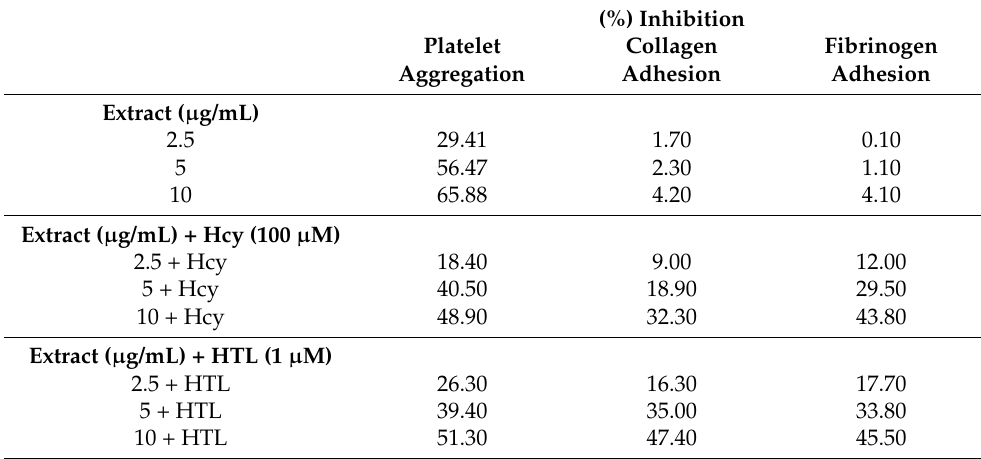
Table 5. Inhibitory effects of different extracts of A. melanocarpa combined with Hcy (homocysteine) and HTL (homocysteine thiolactone) on platelet aggregation and adhesion [121]. (%) Inhibition Platelet Collagen Fibrinogen Aggregation Adhesion Adhesion Extract ( µ g/mL) 2.5 29.41 1.70 0.10 5 56.47 2.30 1.10 10 65.88 4.20 4.10 Extract ( µ g/mL) + Hcy (100 µ M) 2.5 + Hcy 18.40 9.00 12.00 5 + Hcy 40.50 18.90 29.50 10 + Hcy 48.90 32.30 43.80 Extract ( µ g/mL) + HTL (1 µ M) 2.5 + HTL 26.30 16.30 17.70 5 + HTL 39.40 35.00 33.80 10 + HTL 51.30 47.40